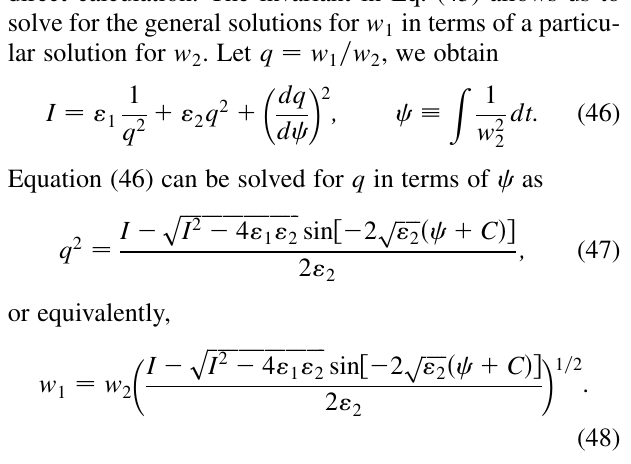
FIG. 1. The matched solution w trary special solution w